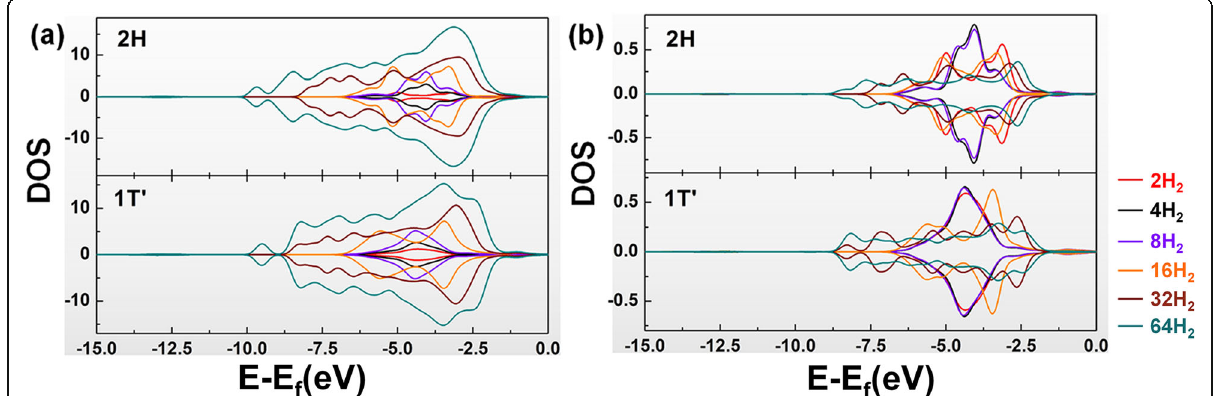
Fig. 4 PDOS results of multiple H 2 adsorption systems for a all and b single hydrogen molecules on 2H-WS 2 and 1T ’ -WS